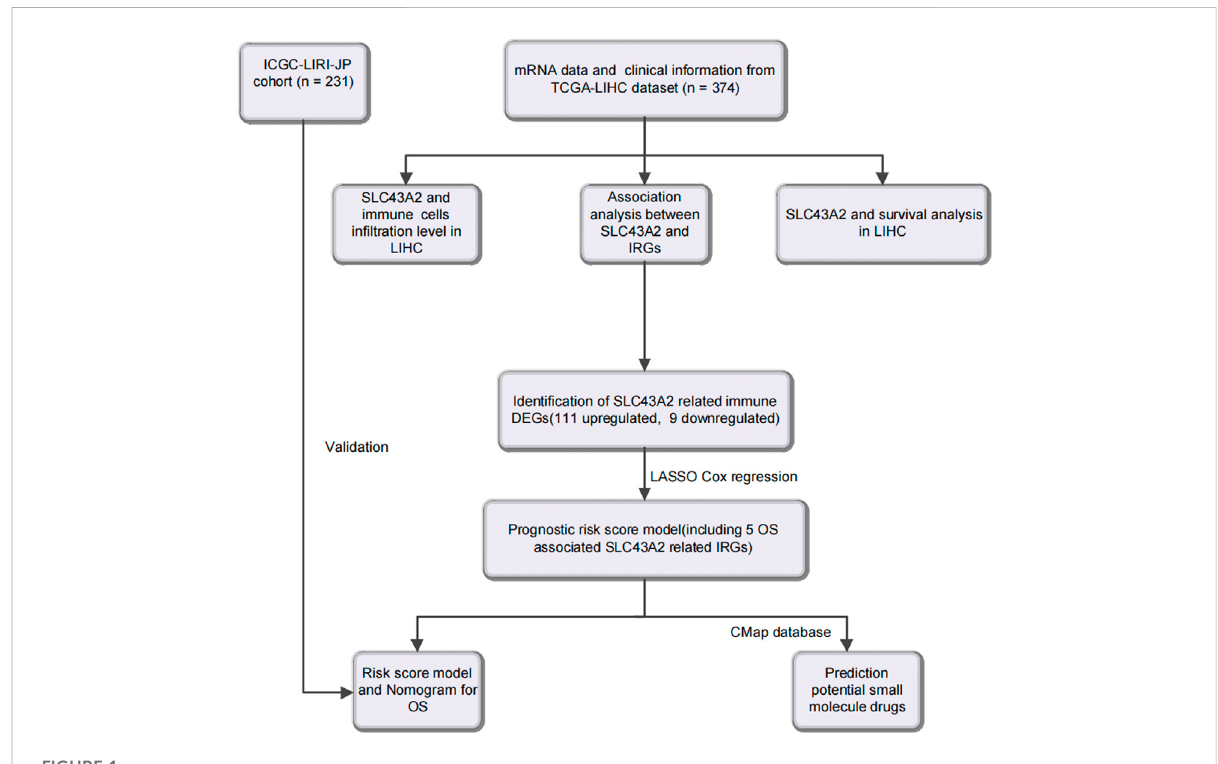
FIGURE 1 Flow diagram of this